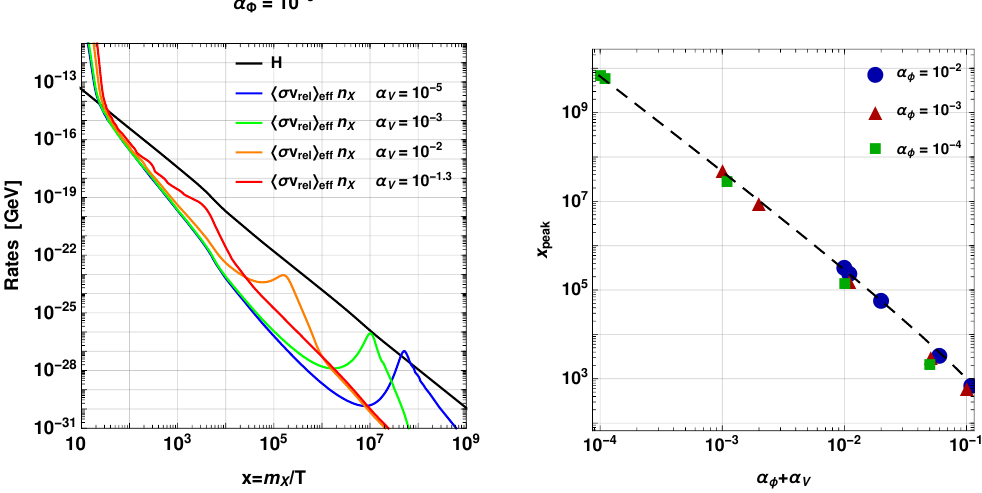
Figure 15 . Left: the DM depletion rate (cid:0) H , for (cid:11) = 10 (cid:0) 3 and di(cid:11)erent values of (cid:11) (cid:8) value of x (cid:17) m =T at which h (cid:27)v rel i e(cid:11) peaks. The symbols correspond to the values determined X numerically, while the line is the semi-analytical prediction eq.